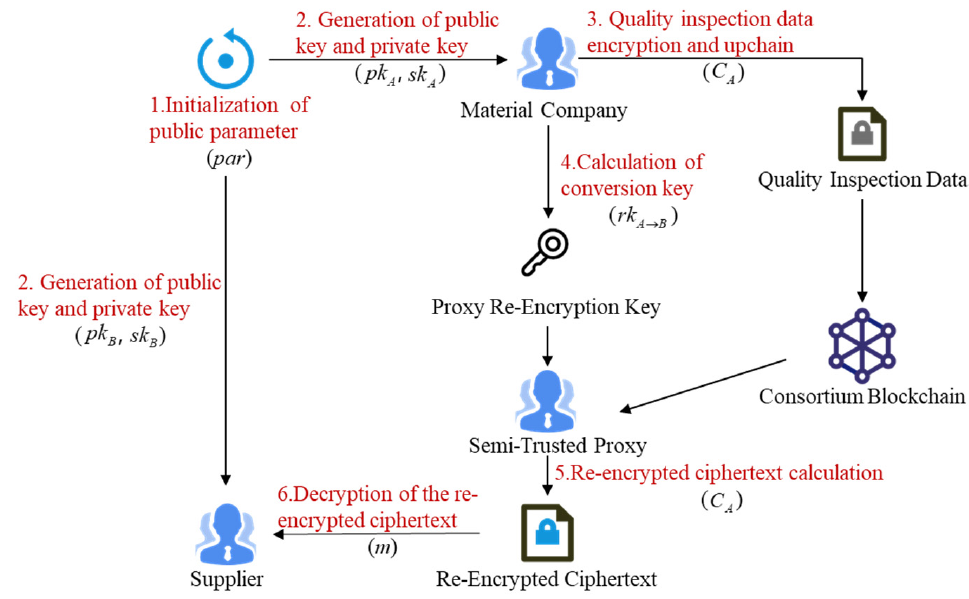
Figure 5. Power material privacy data-sharing method based on PRE. 1. Initialization of public parameter: Setup